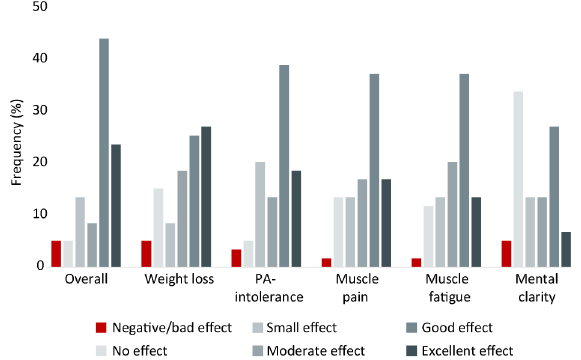
Figure 3. Patient-reported effects of a low-carbohydrate ketogenic diet. PA: physical activity. Based on n = 59 responses.